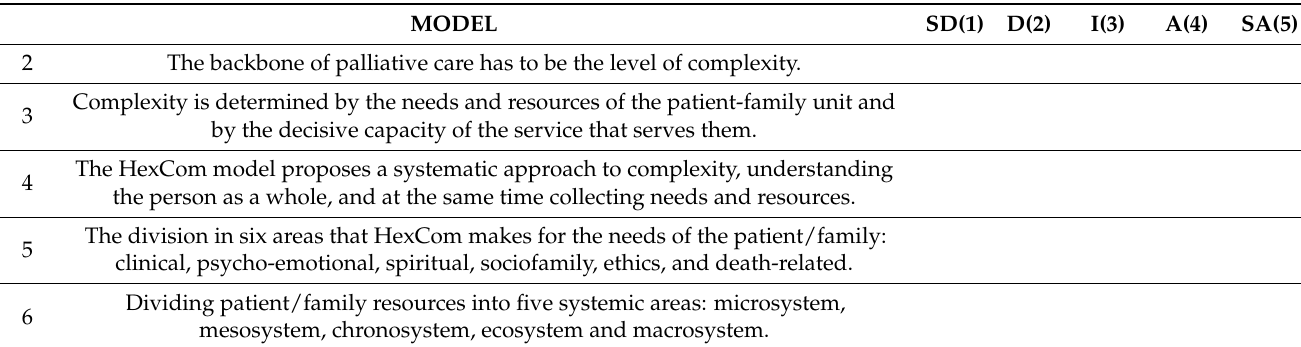
Table 1. Questionnaire to evaluate face validity of the HexCom model and the different associated instruments for complexity